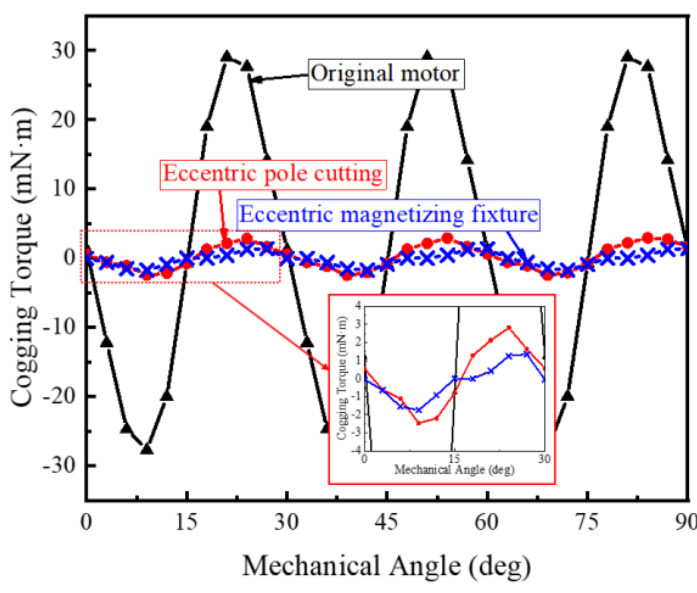
Figure 16. Cogging torque comparison.